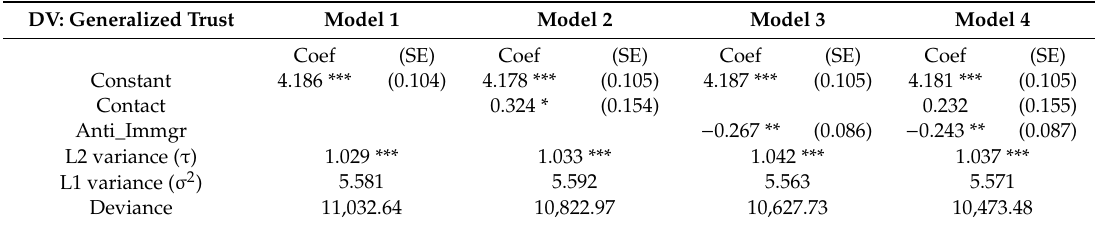
Table 2. Multilevel Linear Regression Analysis (Caucasus Barometer 2017 Georgia. Caucasus Research Resource Center